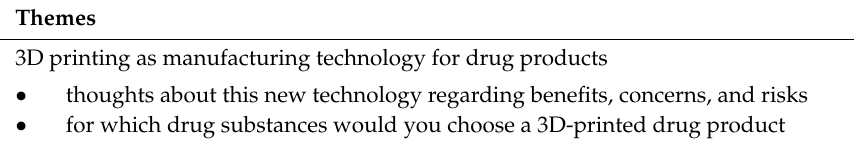
Table 1. Interview guide for the focus group discussions about 3D-printed